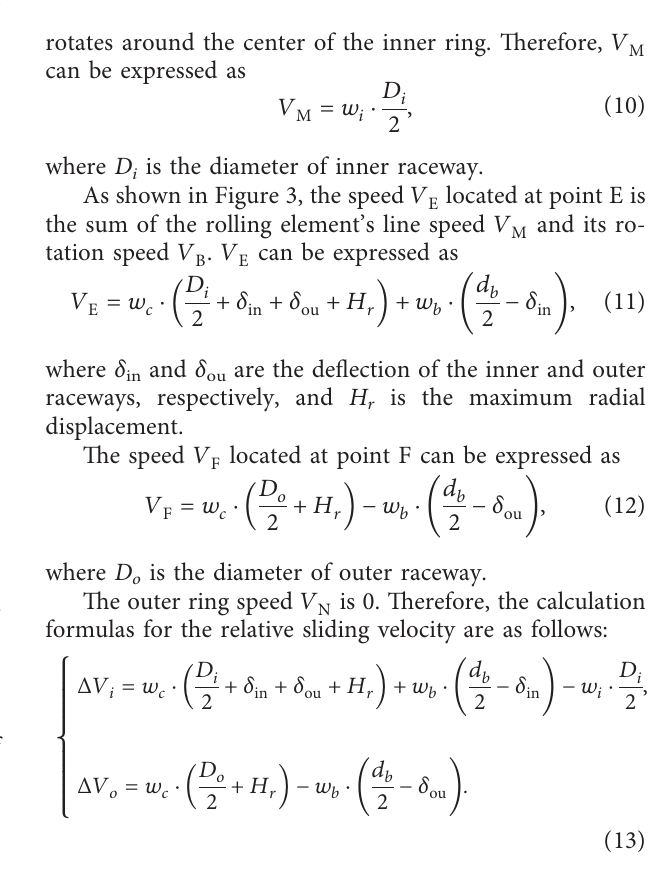
Figure 6: Simplified model for spring and damper of